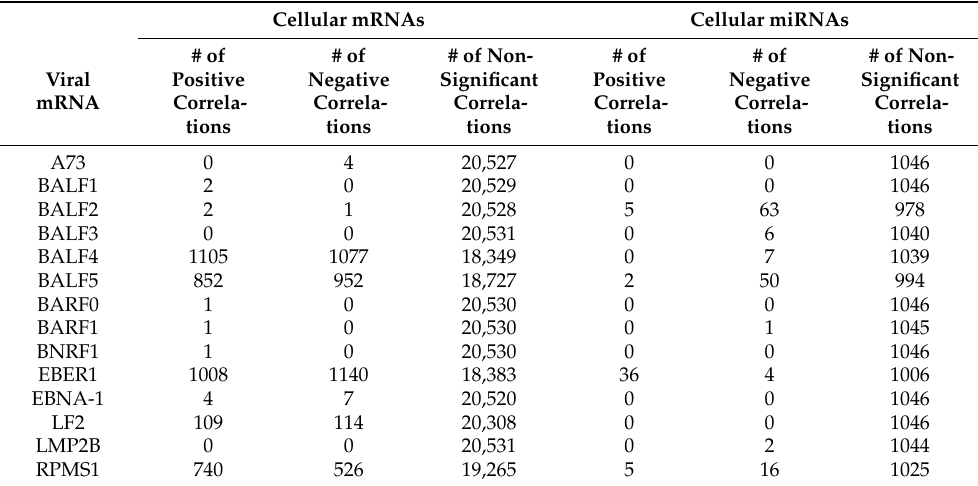
Table 3. Number of cellular mRNAs and miRNAs positively, negatively, or not significantly correlated with viral EBV mRNAs *. Cellular mRNAs